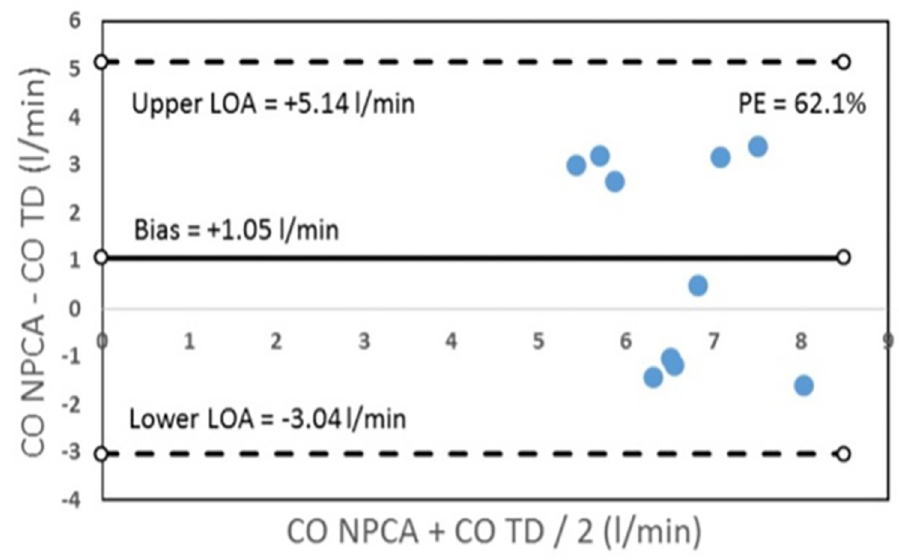
Fig 2. Bland-Altman plot for cardiac output (CO); Bias, limits of agreement (LOA) and percentage error (PE) were calculated.